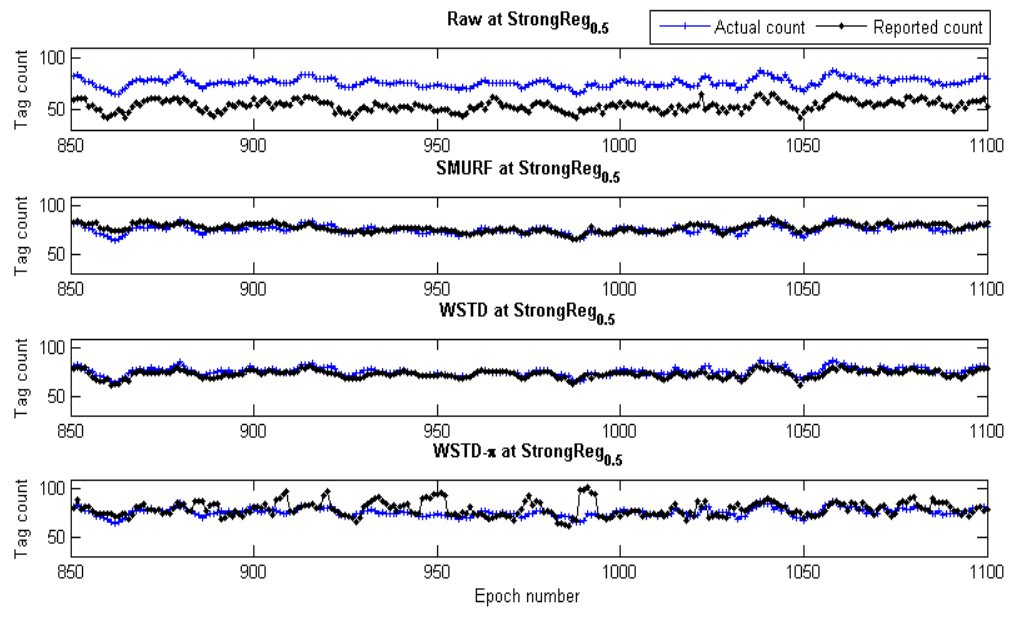
Figure 24. The RMS error of different cleaning schemes as the StrongPercentage parameter varies in the static tags’